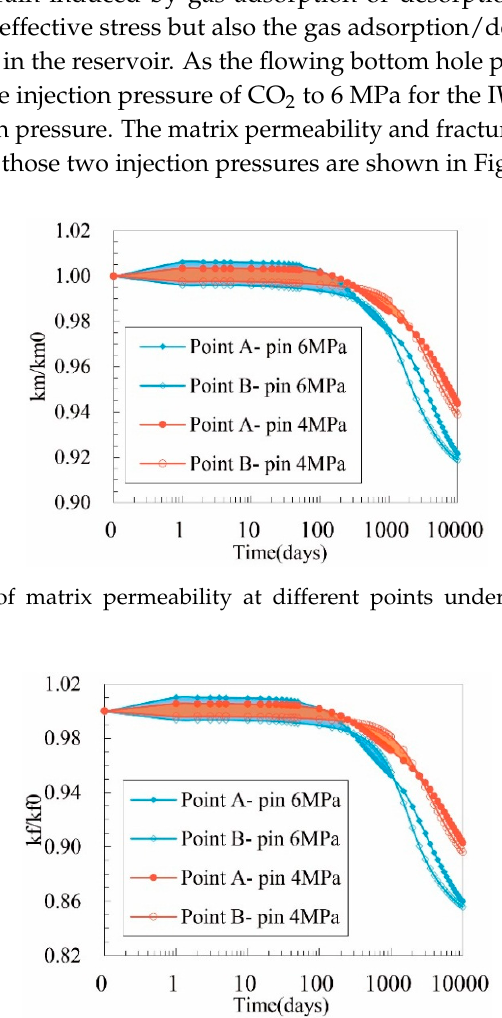
Figure 14. Evolution of fracture permeability at different points.